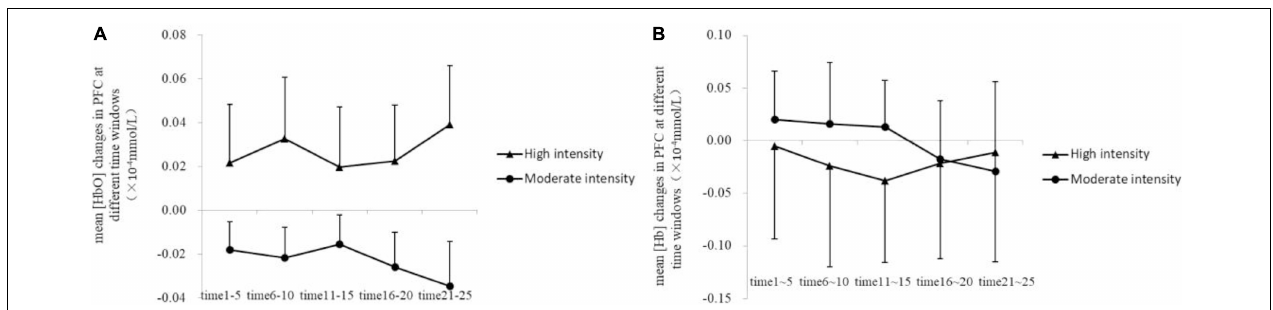
FIGURE 5 | Changes of mean [HbO] (A) and [Hb] (B) in the prefrontal cortex at different time